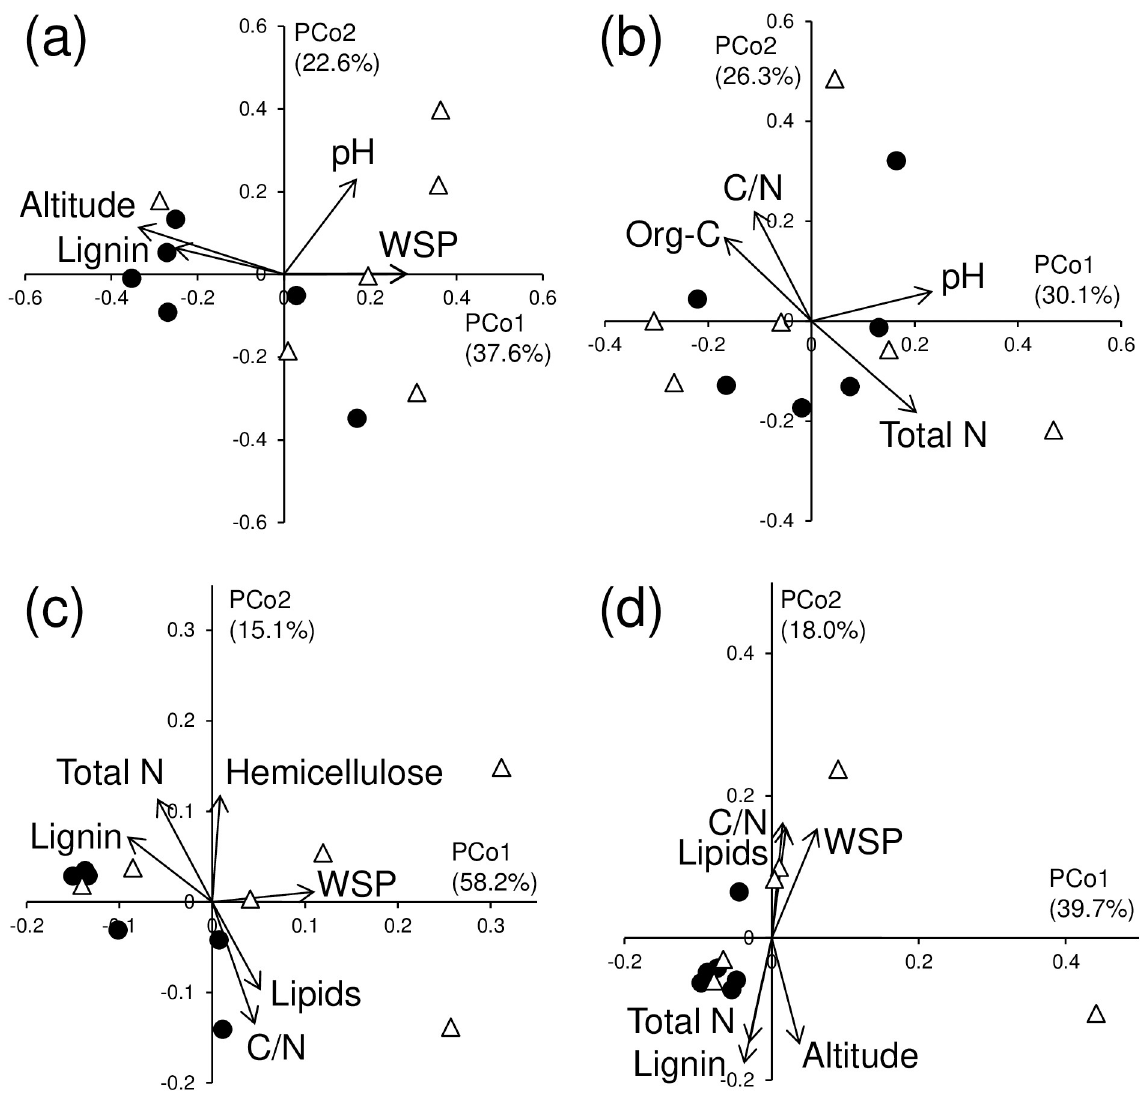
Fig 2. Principal coordinate analysis ordination of (a) bacterial DGGE profiles, (b) fungal DGGE profiles, (c) bacterial CLPP using the ECO plate, and (d) fungal CLPP using the SFN2 plate in the O horizon of Andosols and Cambisols. Filled circle: Andosols; hollow triangle: Cambisols. WSP: water-soluble polysaccharides. Vectors for the significantly correlated ( p < 0.1) environmental variables are superimposed on the plot.